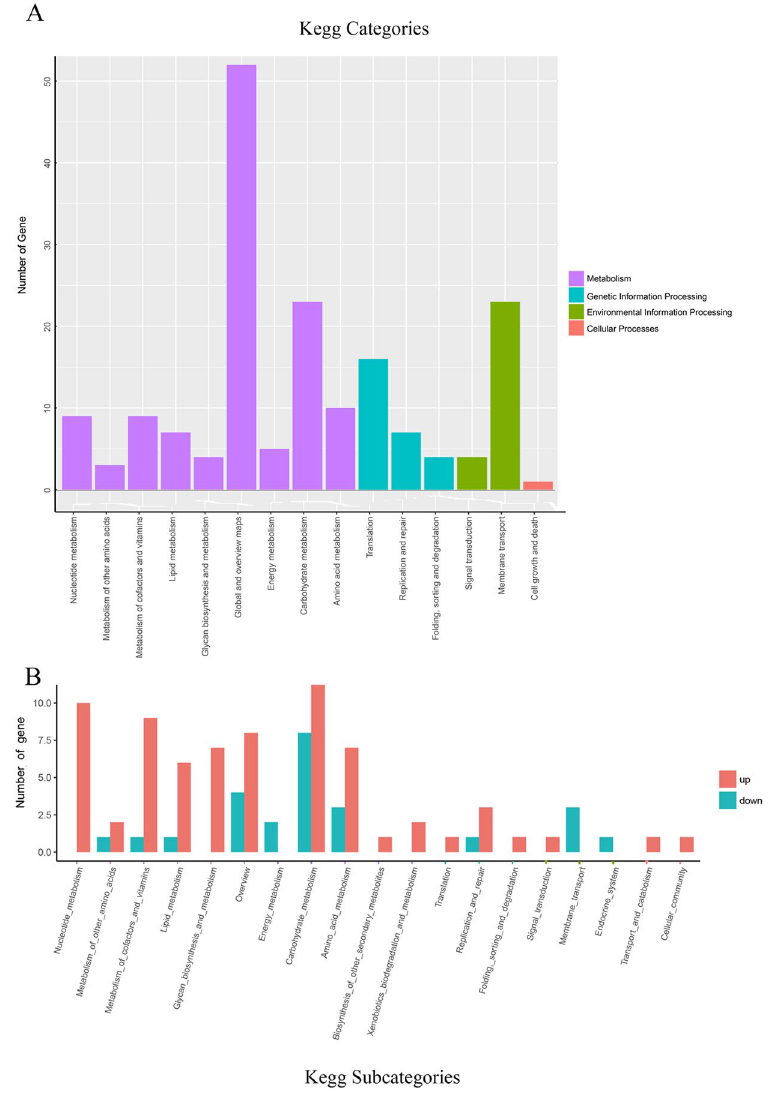
Figure 4. KEGG pathway classification analysis ( A ), and up, down regulation of DE genes in subcategories statistics ( B ). ( A ) The DE genes in the four pathways processes: metabolism (64), genetic information processes (27), environment information processes (27), cellular processes (1), are summarized. The x-axis presents categories pathways, and the y-axis presents the number genes in categories pathway. ( B ) the numbers of up and down regulation genes are summarized in the subcategories pathways belonging to the categories of A. Purple in the X axis label represented metabolism; blue in the X axis label represented genetic information processing; yellow in the X axis label represented environmental information processing; pink in the X axis label represented cellular